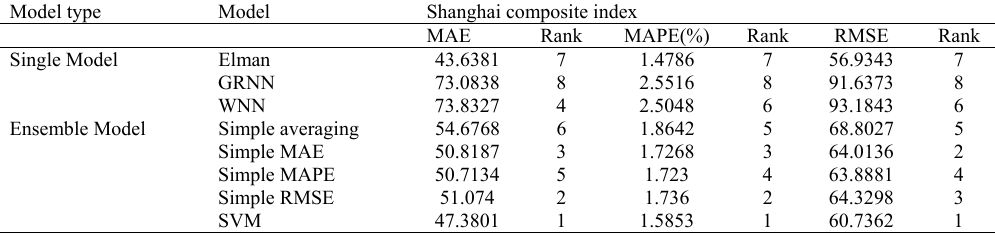
Table 2. Comparison of performance statistics averaging each model over 20 runs in Shanghai composite index.